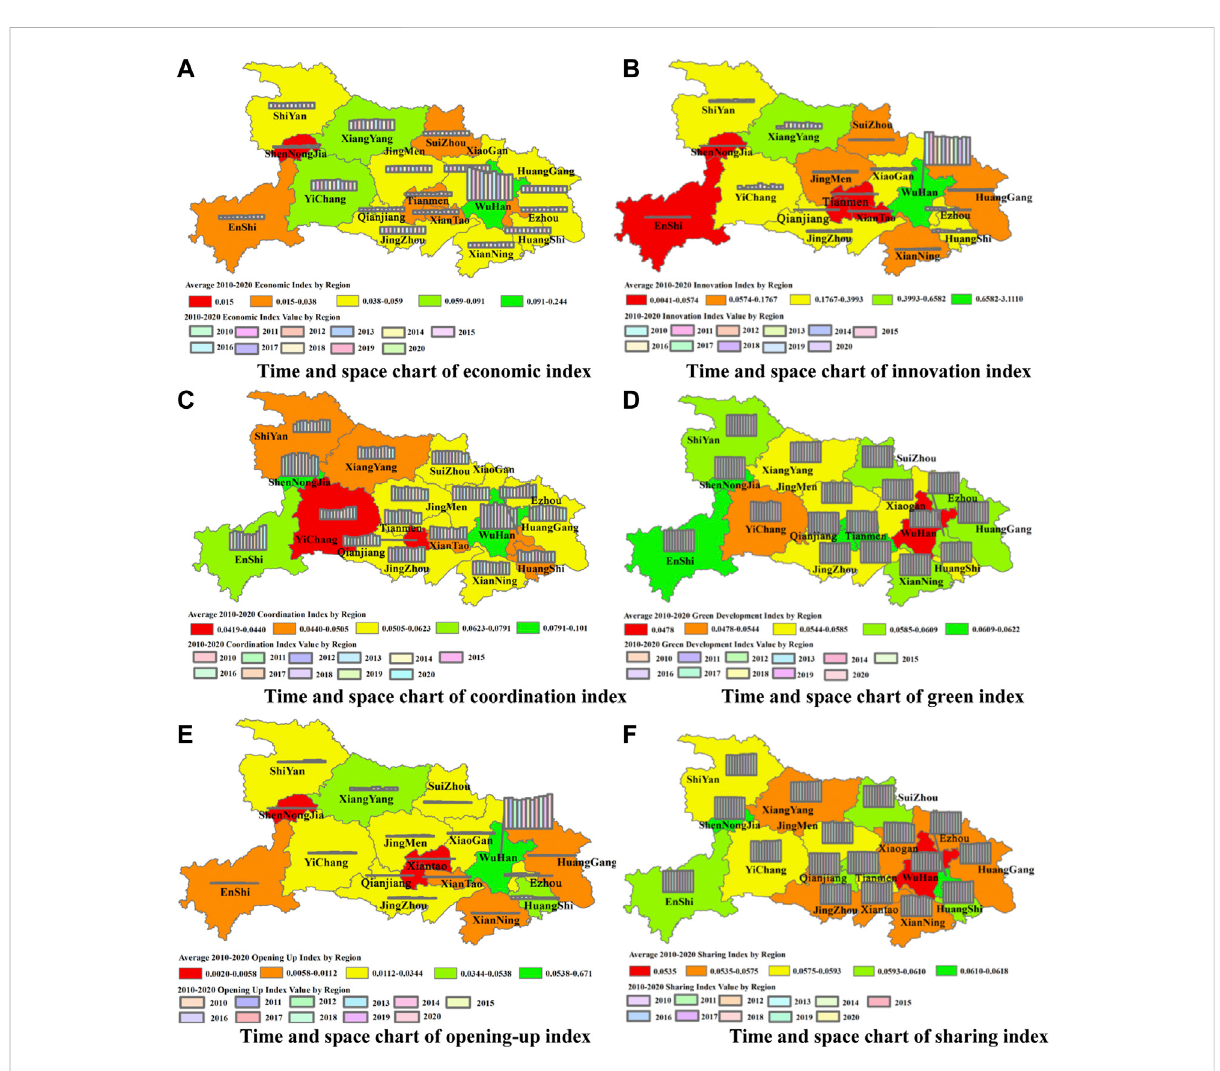
FIGURE 5 (A) Time and space chart of economic index. (B) Time and space chart of innovation index. (C) Time and space chart of coordination index. (D) Time and space chart of green index. (E) Time and space chart of opening-up index. (F) Time and space chart of sharing